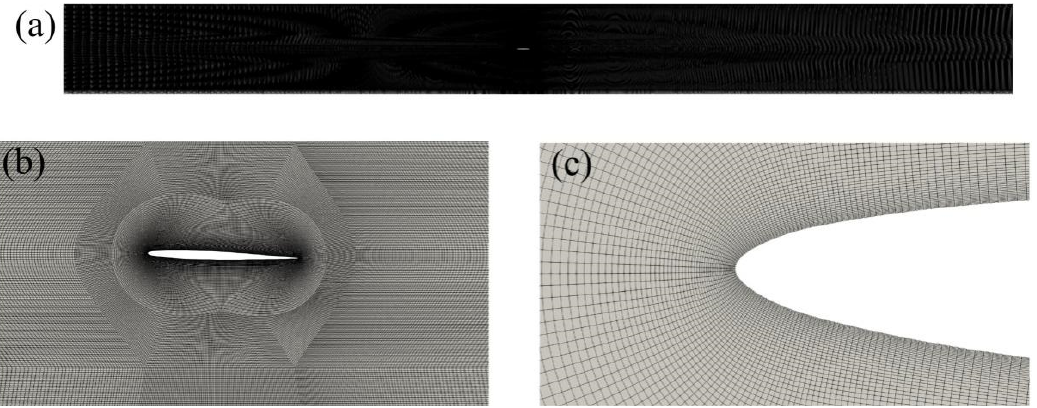
Figure 16. Computational grid for simulation of the gust responses of the NACA 0006 airfoil: ( a ) Global view of the whole computational domain; ( b ) Close view of the mesh near the airfoil; ( c ) Close view of the O-type mesh at the leading edge of the airfoil.